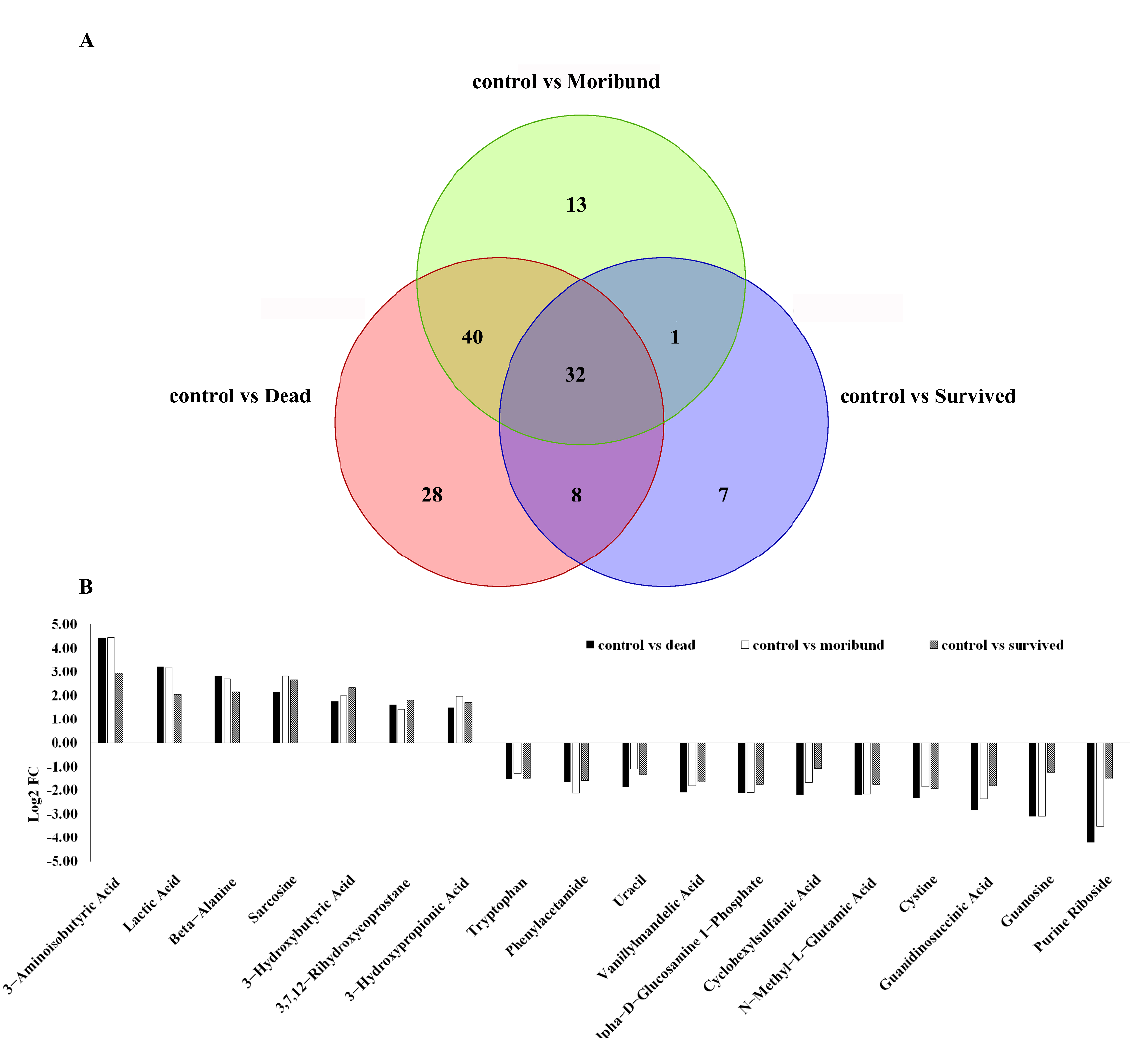
Figure 2. Volcanic map of differential metabolites from three comparisons between control and dead group ( A ), control and moribund group ( B ), and control and group ( C ) of Macrobrachium nipponense . The x - and y -axis are the log2-fold change and the log10 p -value of student ’ s T test between the two compared groups. Red points represent up-regulated metabolites. Green points represent down- regulated metabolites. Black points represent detected but insignificant differences.